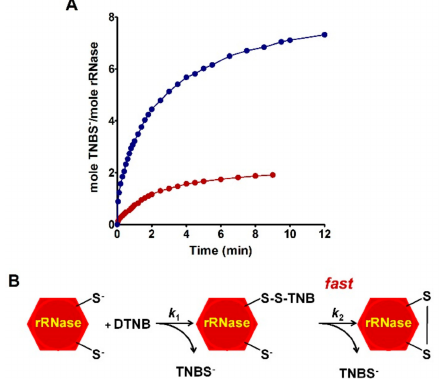
Figure 3. TNBS – release after reaction of the rRNase with substoichiometric DTNB. ( A ) Fully reduced rRNase (1.25 µ M, 10 µ M protein –SH) was reacted with 1.25 µ M DTNB at pH 5.0, 25 ◦ C (red line); the rRNase (1.25 µ M, 10 µ M protein –SH) was reacted with 5.0 µ M DTNB at pH 5.0, 25 ◦ C (blue line). ( B ) Schematic representation of the reaction of the rRNase with stoichiometric